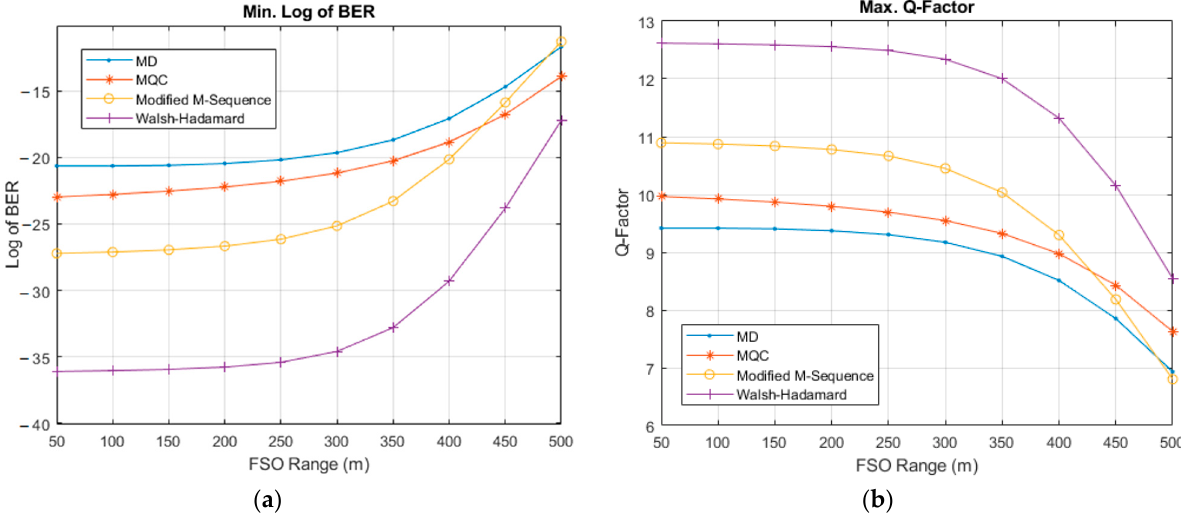
Figure 11. Performance of the system in stormy weather for the AWGN channel: ( a ). min. log of BER; ( b ). max. Q ‐ factor. Table 5. Performance degradation with the increasing of FSO range in the AWGN channel.